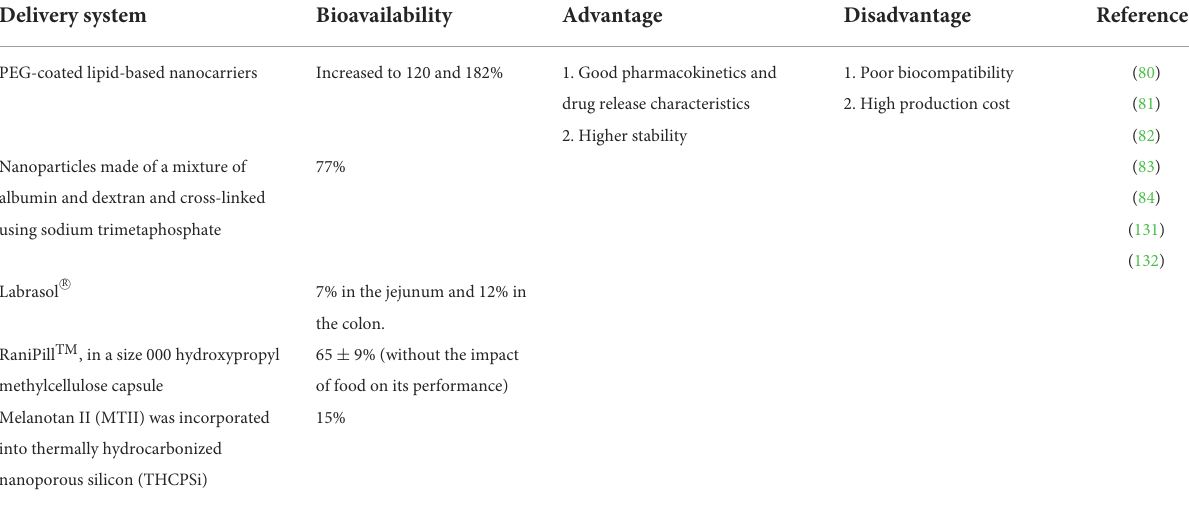
TABLE 4 Application and characterization of polymeric